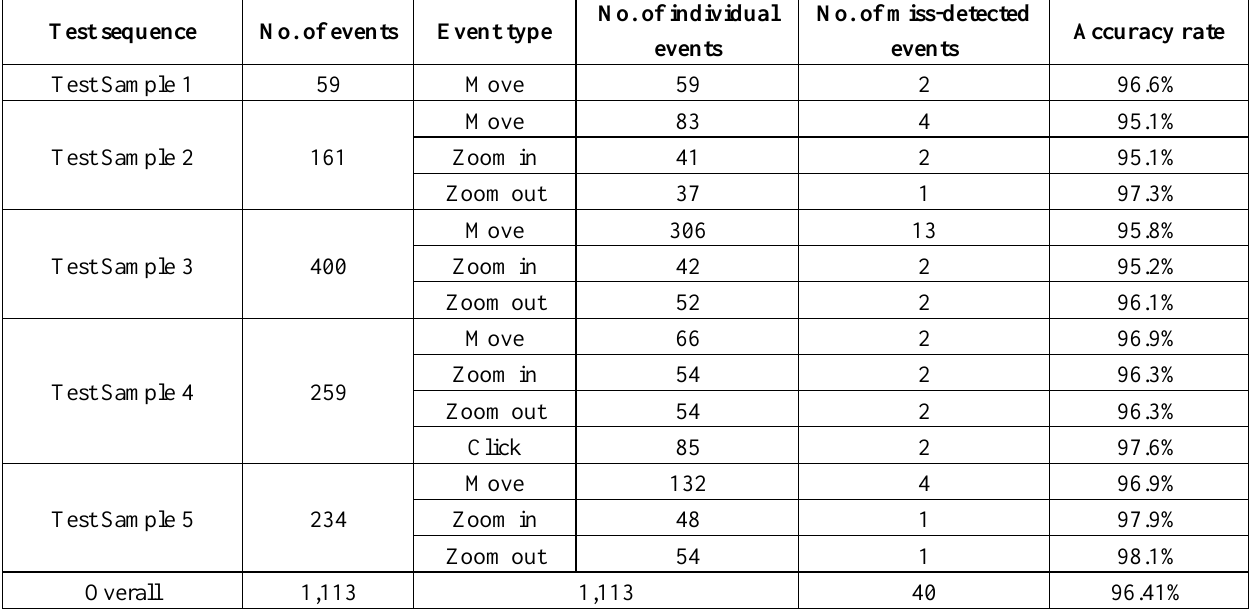
Table 2. Experimental data of the proposed technique on multi-touch event identification